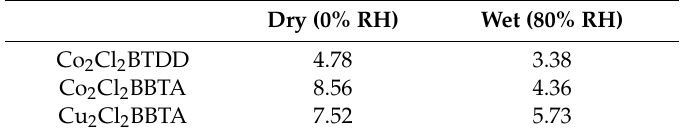
Table 3. Saturation NH 3 breakthrough capacities value at 0.1% of